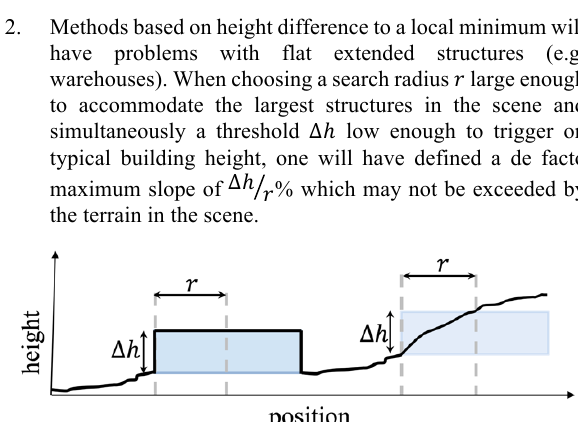
Figure 1. The problem with height-based thresholds and low